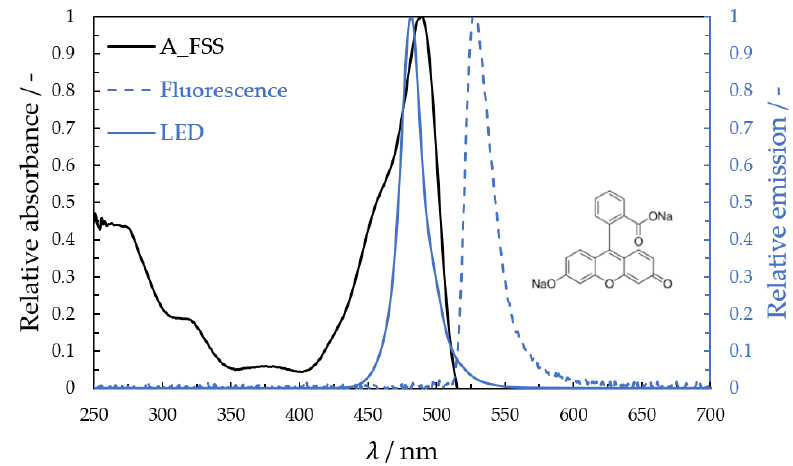
Figure 2 . Absorbance and emission spectrum of fluorescein sodium salt and the intensity spectrum of the 470 nm light source .